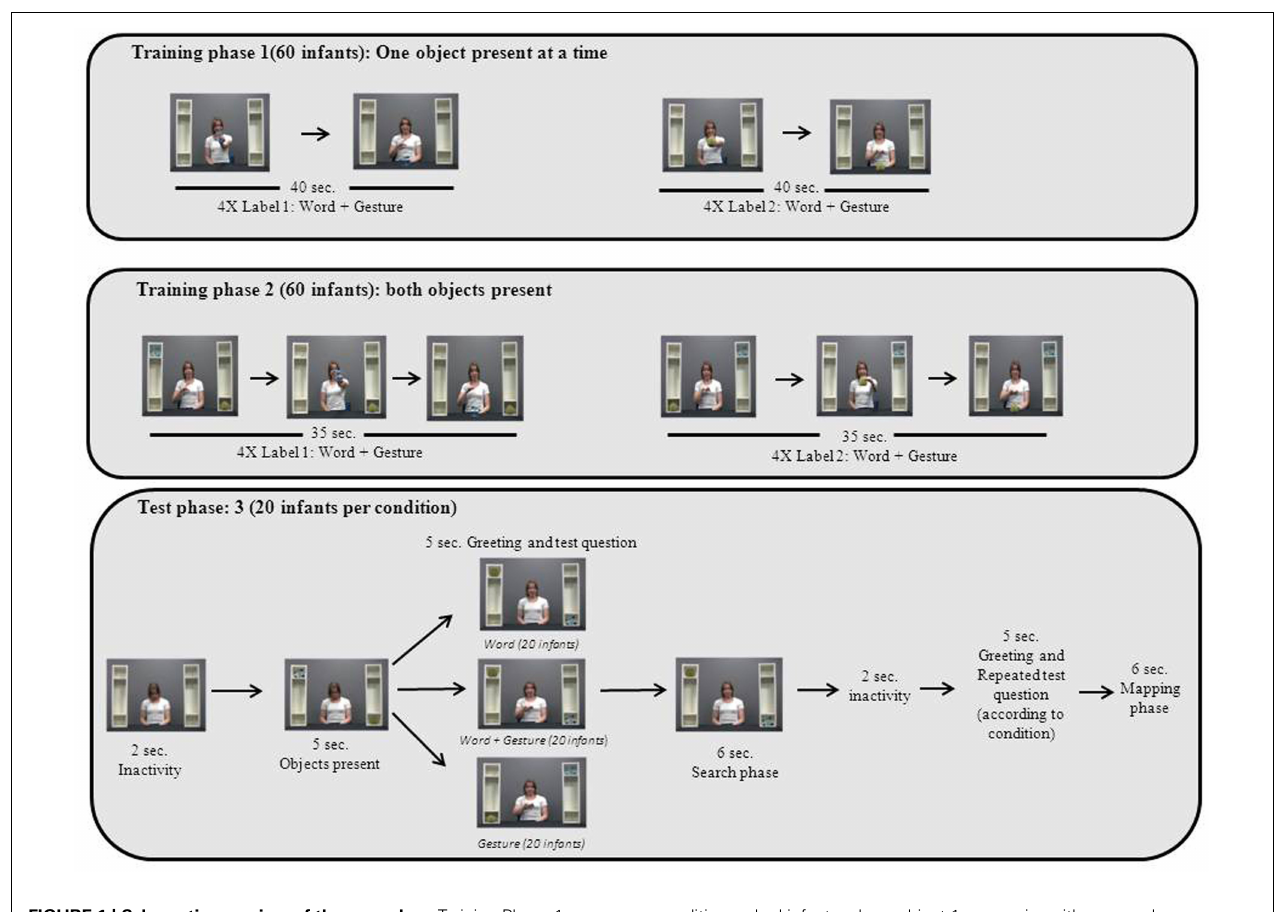
FIGURE 1 | Schematic overview of the procedure. Training Phase 1: E ostensively drew attention to object 1 and then labeled it four times using multimodal labels.The same was repeated for object 2.Training Phase 2: E announced her intention to find object 1. She then found it and ostensively labeled it four times.The same was repeated for object 2.Test Phase (depicts 1 of 4 trials): E looked up and, according to the